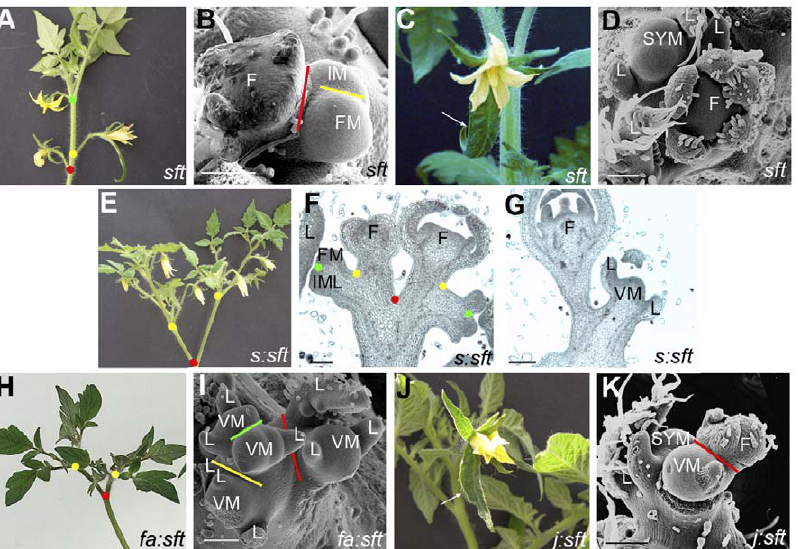
Figure 4. Inflorescence phenotype of tomato mutants. (A) and (B) Inflorescence of sft mutant showing several flowers; (C) and (D) Inflorescence of sft mutant with solitary flower; (E–G) s:sft double mutant; (H) and (I) fa:sft double mutant; (J) and (K) j:sft double mutant. In microscopic pictures, colour bars show the clefts that occurred sequentially when new meristems were initiated to build-up the inflorescence. Red: 1 st ; yellow: 2 nd , green: 3 rd . Dots of same colours show the corresponding branching in macroscopic inflorescence picture. In C and J, arrows point at leaf-like sepals. Genotype abbreviations: fa , falsiflora ; j , jointless ; s , compound inflorescence ; sft , single flower truss. Annotations: F, flower; FM, flower meristem; IM, inflorescence meristem; IML, IM-like; L, leaf; S, shoot; SYM, sympodial meristem; VM, vegetative meristem. Bars=100 m m.